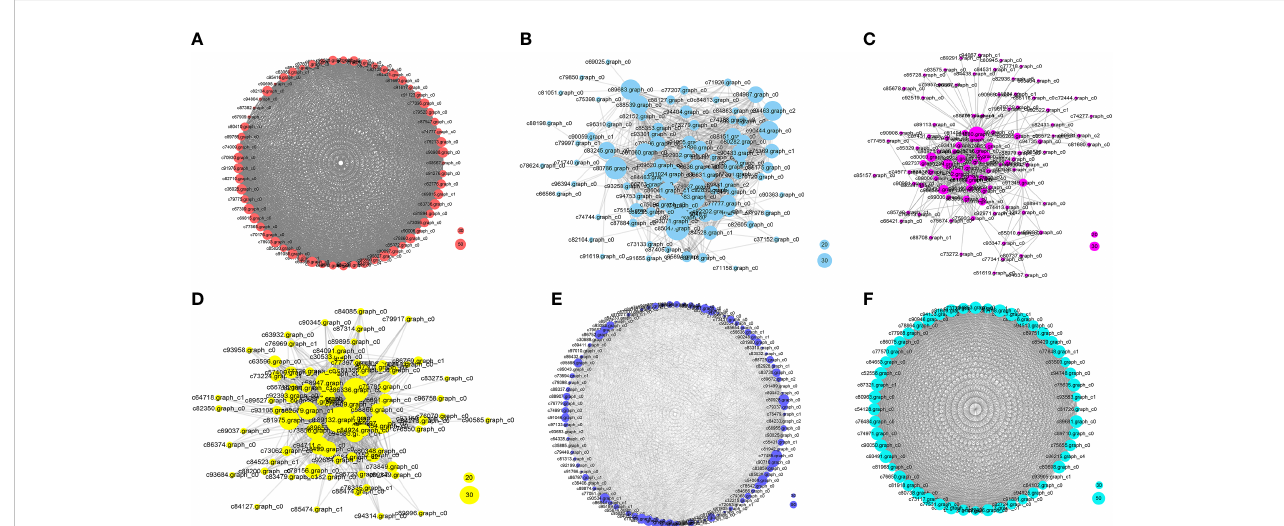
FIGURE 8 Network analysis of the collected modules. The bubble size indicates connect degree of each gene. (A-F) The networks represented greenyellow, black, brown, blue, red and tan